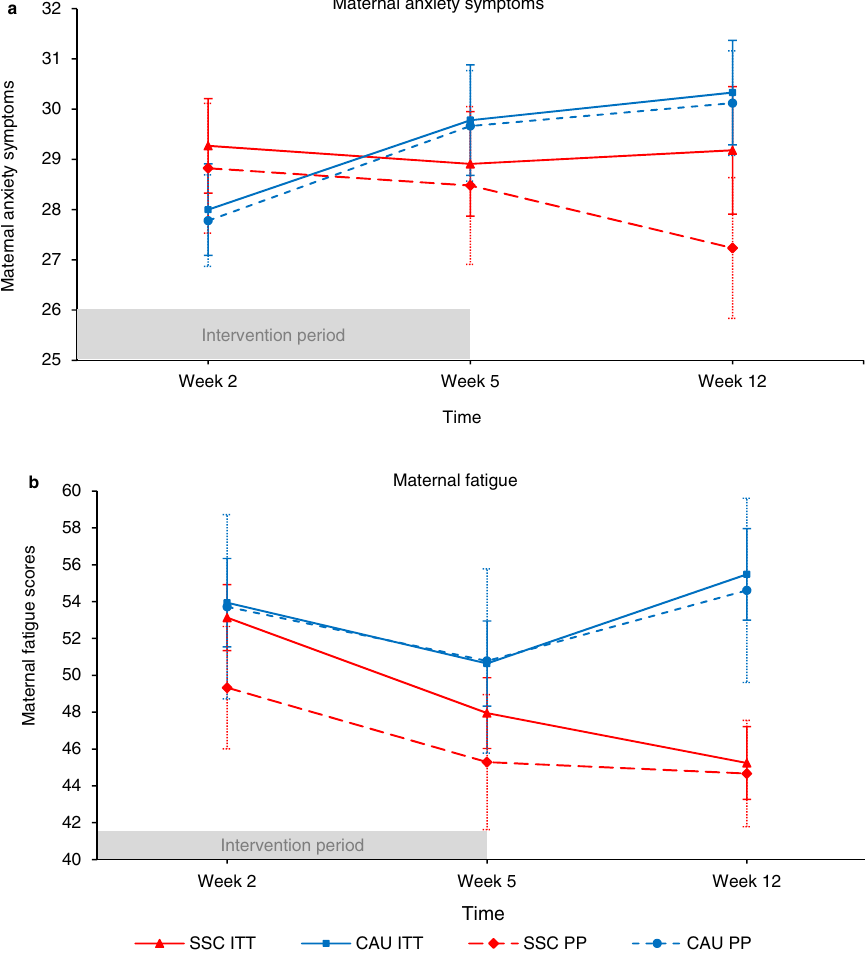
Figure 3. Maternal postnatal anxiety ( a ) and fatigue ( b ) symptoms during the first twelve postnatal weeks in the skin-to-skin contact (SSC) and care-as-usual (CAU) condition for the intention-to-treat (ITT) selection and per-protocol (PP) selection. Winsorized data is presented for all variables that included outliers. Error bars represent standard errors of the mean. In intention-to-treat analyses, SSC mothers displayed a stability of anxiety symptoms and a decrease of fatigue over time. Care-as-usual mothers showed an increase of anxiety symptoms over time and a decrease in fatigue symptoms from week 2 to 5 followed by an increase at week 12. In per-protocol analyses, the results for anxiety symptoms were replicated but no significant effect was found for fatigue